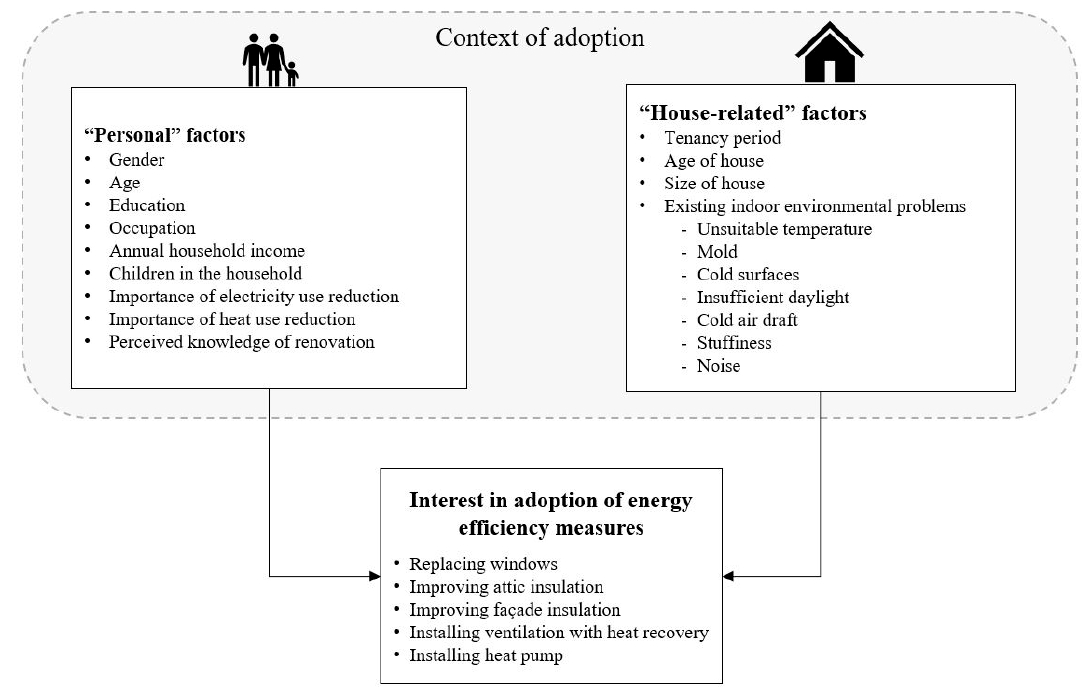
Figure 1. Schematic representation of the role of context on the adoption of energy e ffi ciency measures.